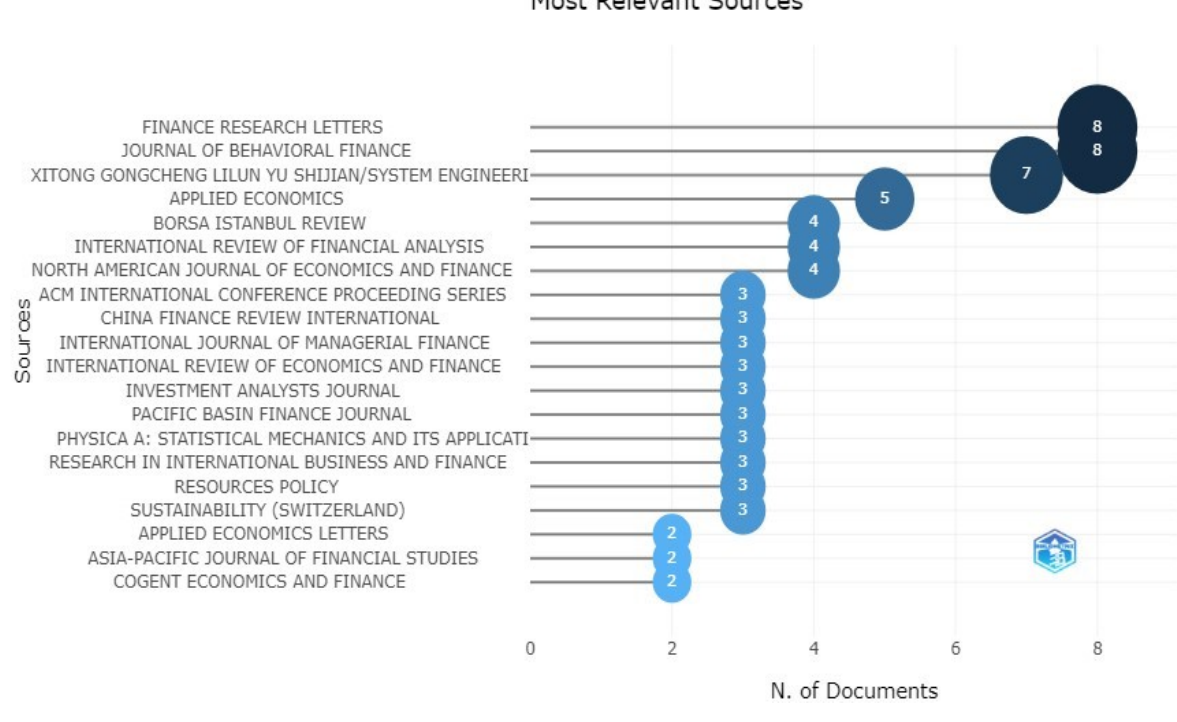
Figure 7. Bibliographic coupling.